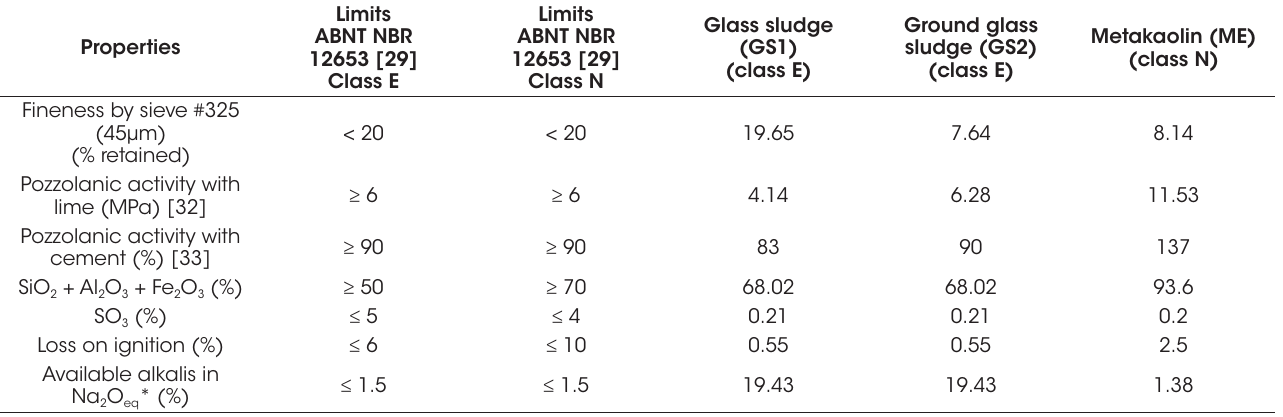
Limits for classification of pozzolanic materials according to NBR 12653